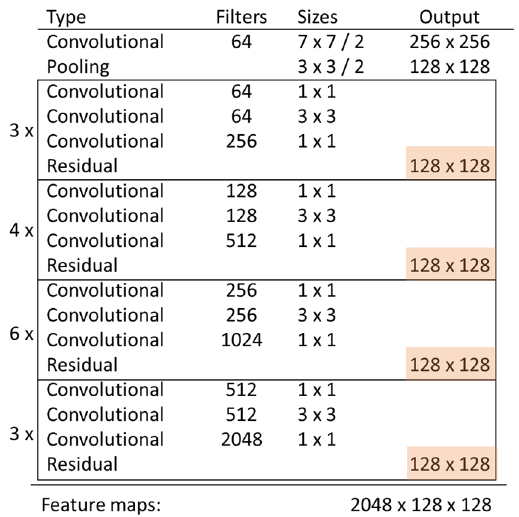
Figure 4. CNN architecture; note that the shaded parts are modifications from the original ResNet- 50 [20] to improve the resolution of the output. 50 [20] to improve the resolution of the